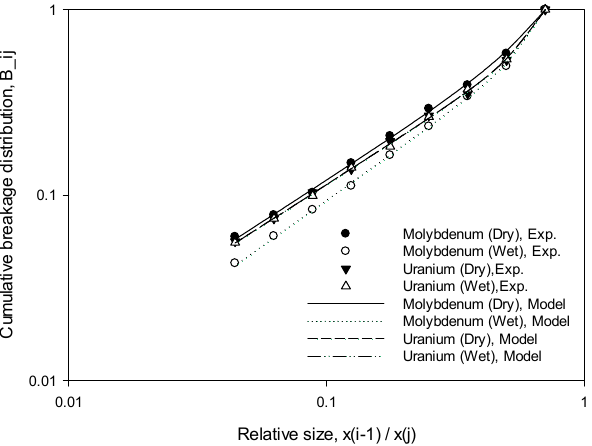
Figure 4. Cumulative breakage distribution function obtained from batch grinding test results.